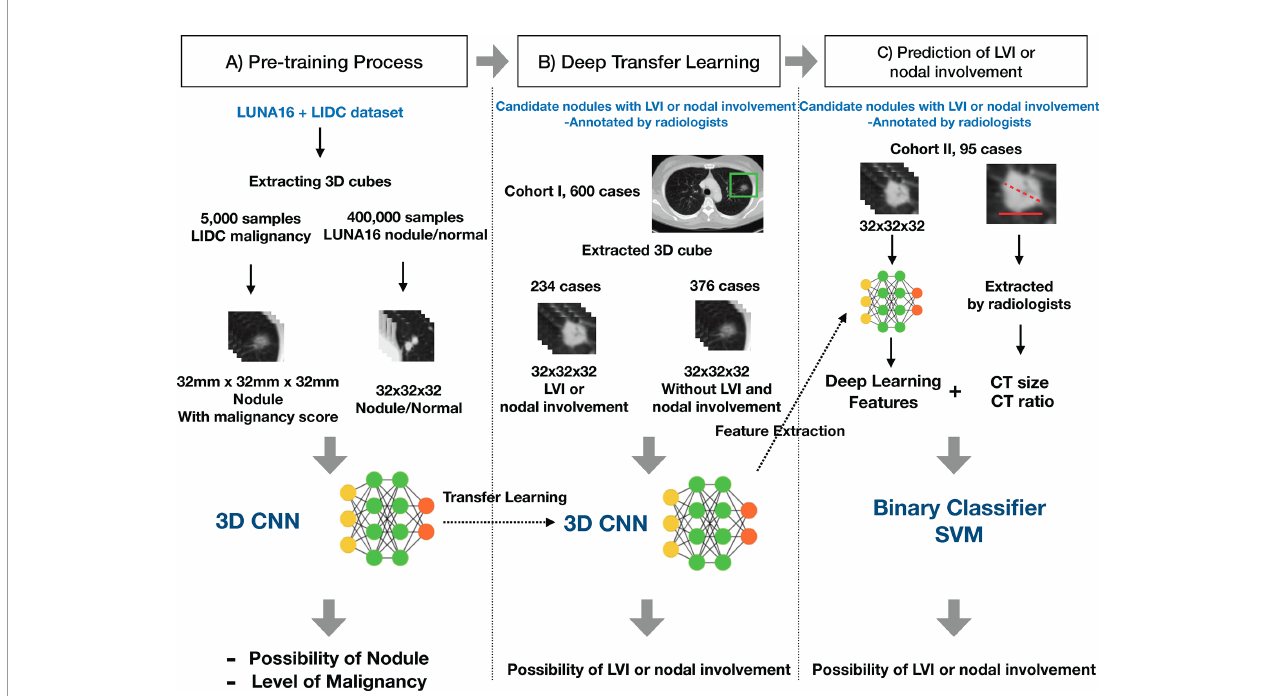
FIGURE 3 | Overall process of the DeepCUBIT algorithm. (A) Pre-training Process: Nodule samples and malignancy samples are presented to pre-train. (B) Deep Transfer Learning: Predicting the LVI or nodal involvement by fi ne-tuning the model with weights of pre-trained weights. (C) Prediction of LVI or nodal involvement: Feature integration and prediction of LVI or nodal involvement for extra validation